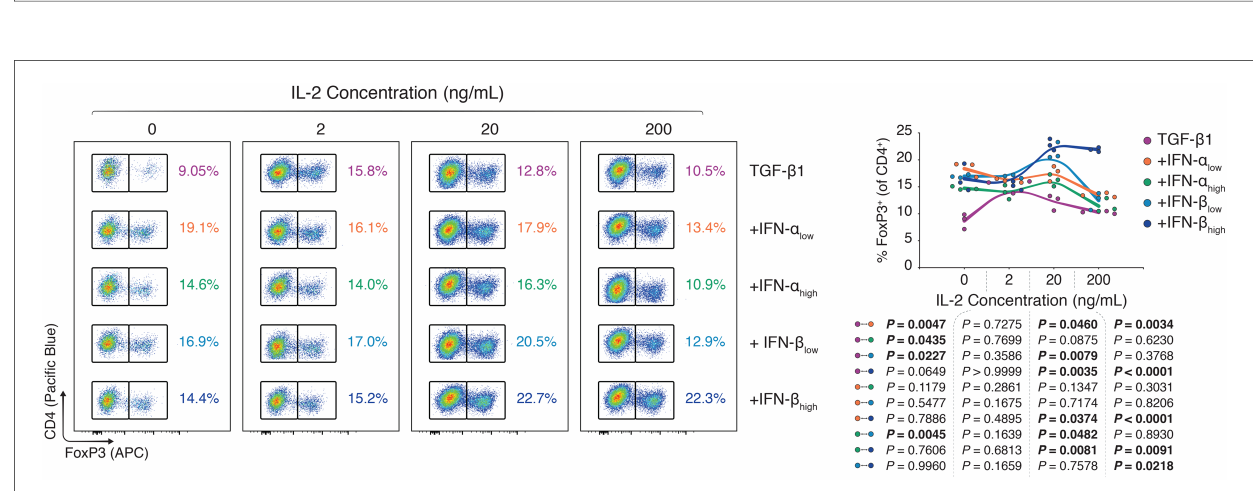
FIGURE 3 Type I interferons do not promote FoxP3 T reg inducing effect under strict circumstances of CD4 purity . Murine CD4 + CD25 − T cells were magnetically isolated using a double pass CD4 isolation and expanded for three days without stimulants (NS), or with anti-CD3 (1 μ g/ml), anti-CD28 (1 μ g/ml), and TGF- β 1 (10 ng/ml; TGF- β 1). In separate wells, IL-2 (20 ng/ml; +IL-2), IFN- α ml; +IFN- β low ), or IFN- β high (10,000 IU/ml; IFN- β high ) were added to the TGF- β 1 condition ( n =3 technical replicates/condition; 2 experiments). ( A ) Flow cytometric analysis and box plots of FoxP3 + T regs among CD4 + T cells. ( B ) Flow cytometric analysis and box plots of Ki-67 mean fl uorescence intensities (MFIs) among CD4 + FoxP3 + T regs and CD4 + FoxP3 − non-T regs . Data represent boxplots with median, interquartile range, minimum, maximum, and all individual data points of the denoted experimental groups. P values were calculated with one-way analyses of variance followed by Holm- Š ídák multiple comparison tests. IFN- α , interferon alpha; IFN- β , interferon beta; IL-2, interleukin 2; MFI, mean fl uorescence intensity; NS, non-stimulated; TGF- β 1, transforming growth factor beta 1.